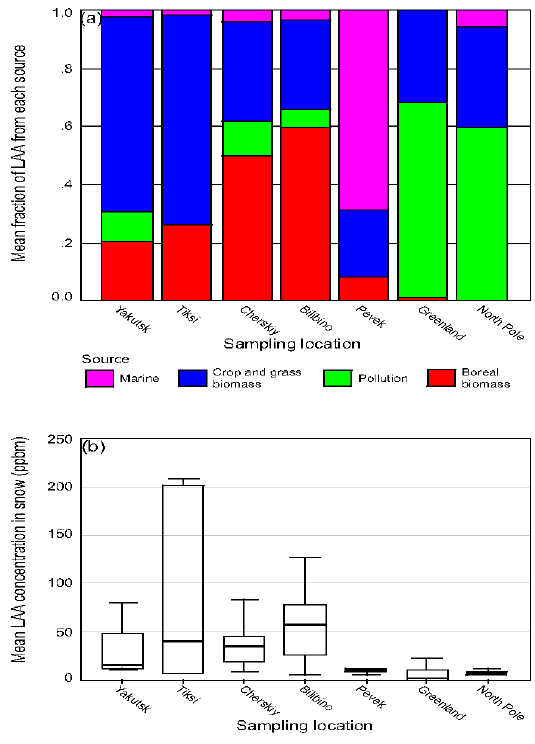
Figure 3. (a) Average fractional source contributions to the LAA concentration in snow for each of the main sampling locations for the 2008 study. (b) Absolute concentrations of LAA in snow for each of the sites shown in Figure 3a. The boxes represent the quartile range while the interior lines represent the means. The error bars subsume the 95% confidence interval.